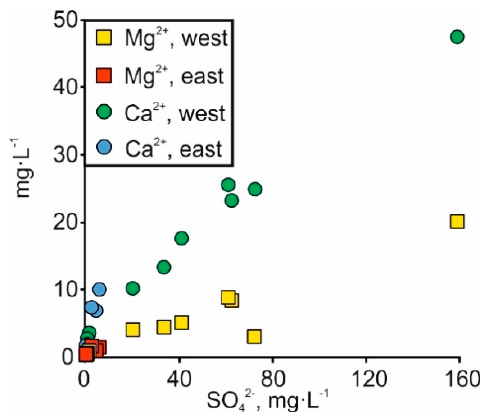
Figure 7. Ca 2+ , Mg 2+ and SO 42 − variations in western and eastern streams on the catchment of Lake Saana.